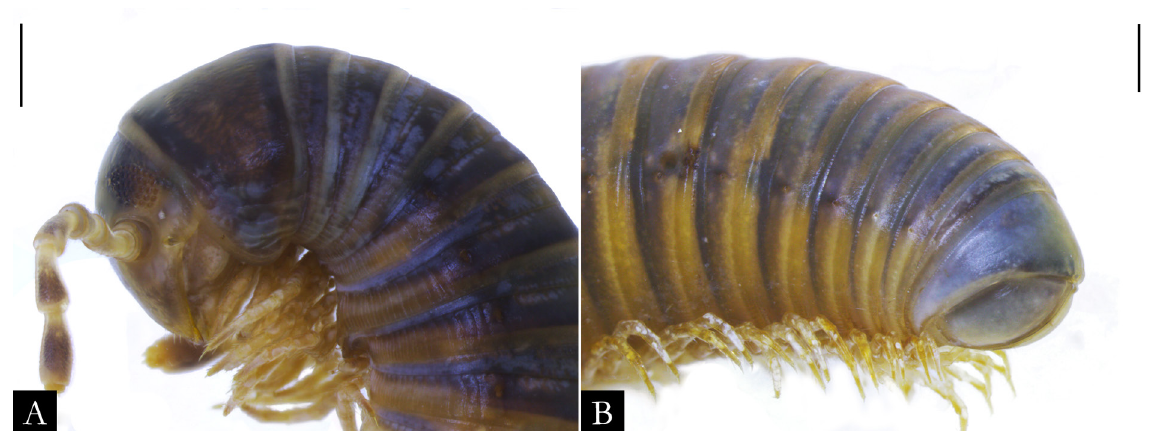
Fig. 125. Pseudonannolene silvestris Schubart, 1944, ♂ (IBSP 2272), in lateral view. A . Anterior region. B . Posterior region. Scale bars = 1